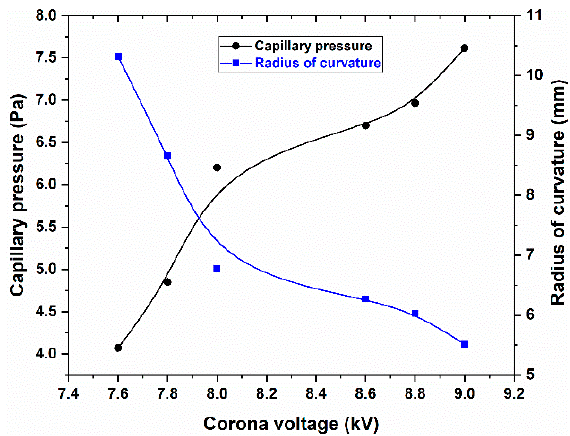
Figure 6. Capillary pressure and curvature radius of the liquid lens as a function of the voltage when the liquid silicone bulged outside of the tube.